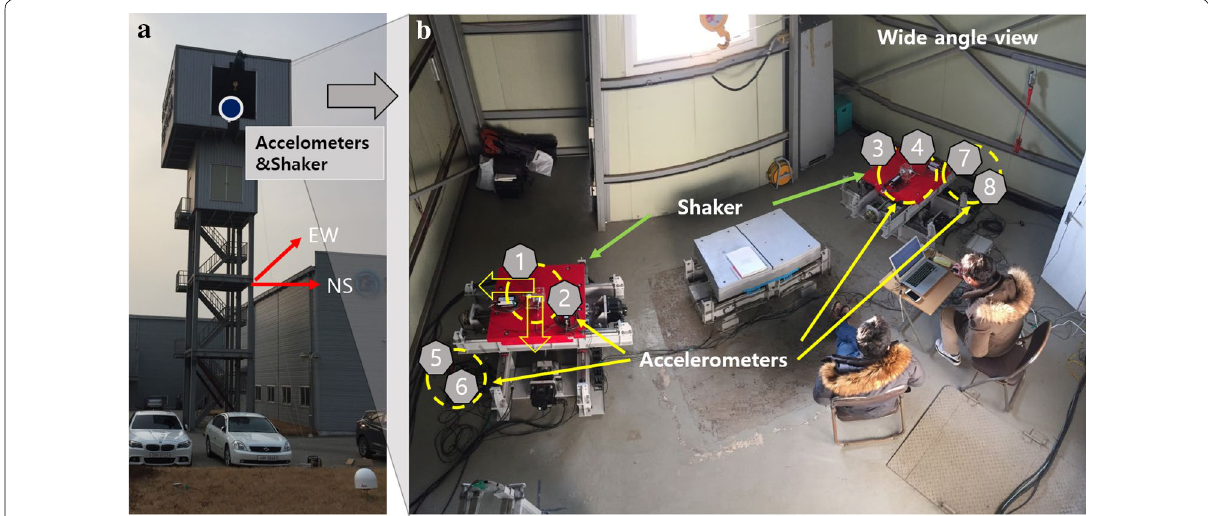
Fig. 7 a 5 story test building, b shakers and accelerometers on the top